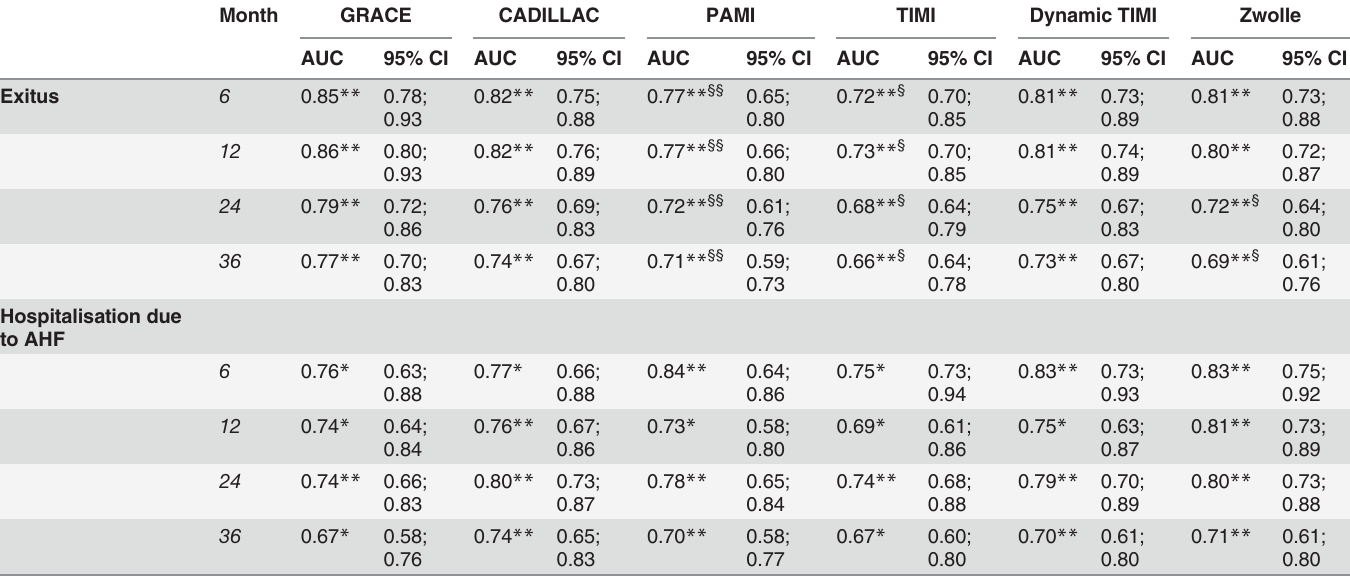
Table 5. The AUC of six scoring models for mortality and rehospitalisation at a given time point and statistical significance of difference between AUC using DeLonges test (reference model GRACE